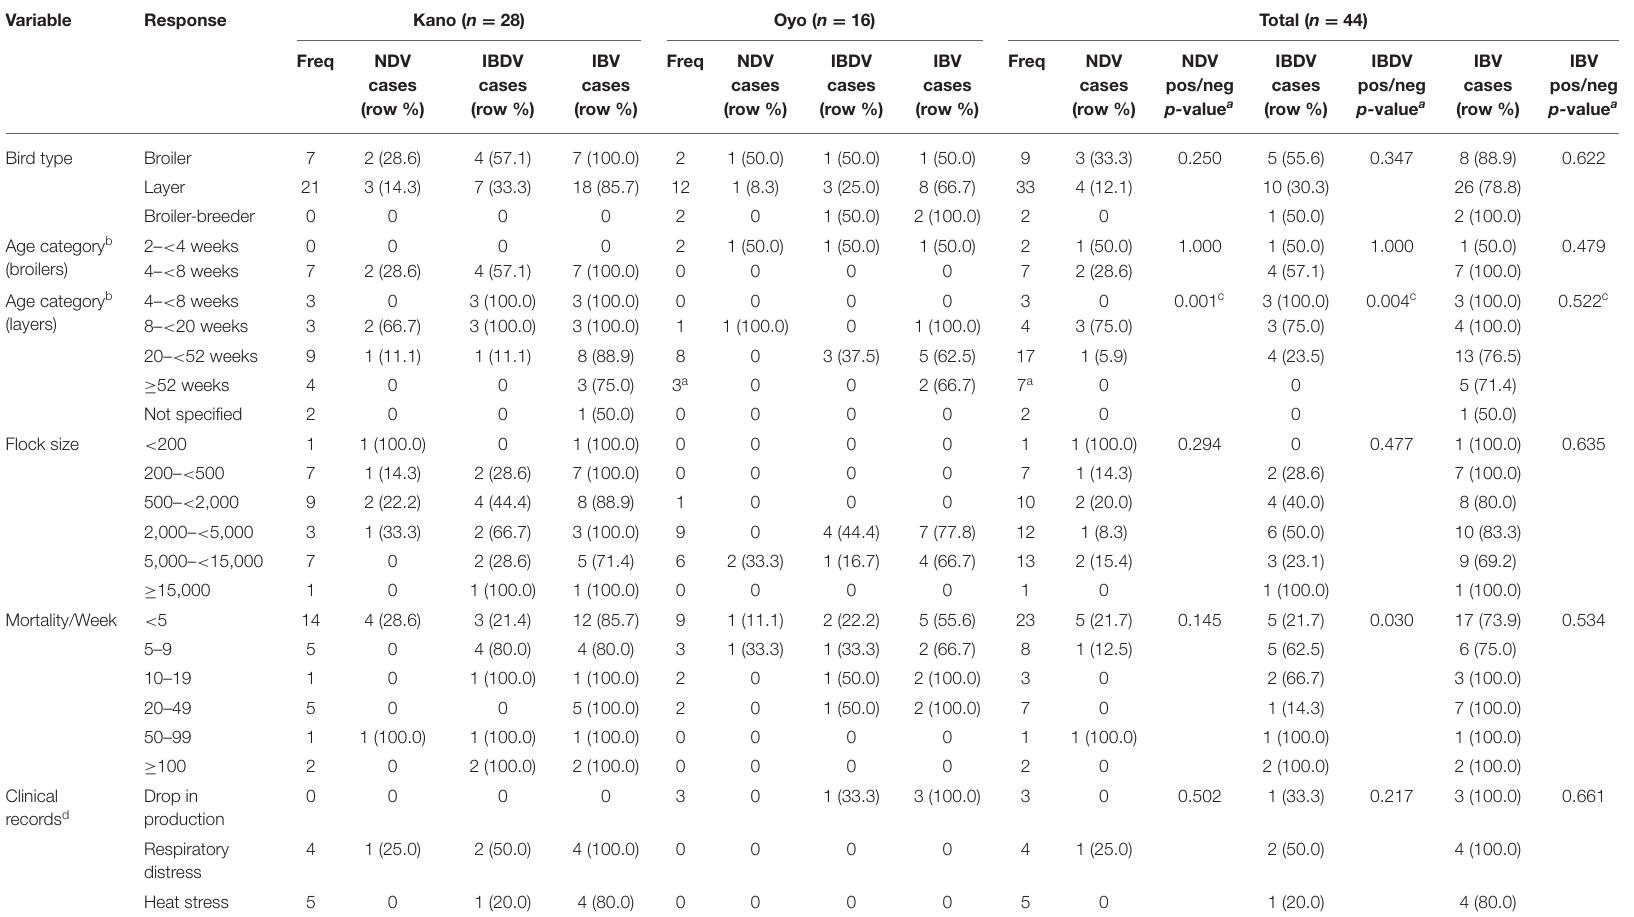
TABLE 1 | Descriptive analysis of study flocks, evaluating associations between select flock variables and cases of NDV, IBDV, and IBV as determined by rRT-PCR.